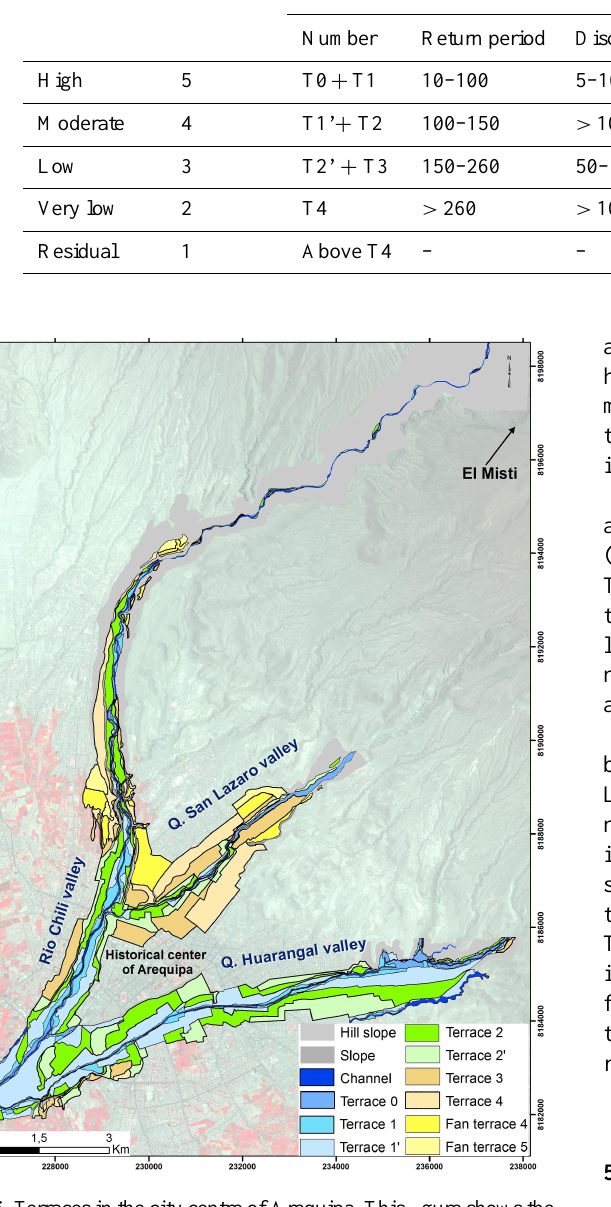
Fig. 6. Terraces in the city centre of Arequipa. This figure shows the system of terraces in the centre of Arequipa, from river channels to fan terraces. The delineated terraces are completed with land use types identified on each of the banks of R´ıo Chili (see Fig.